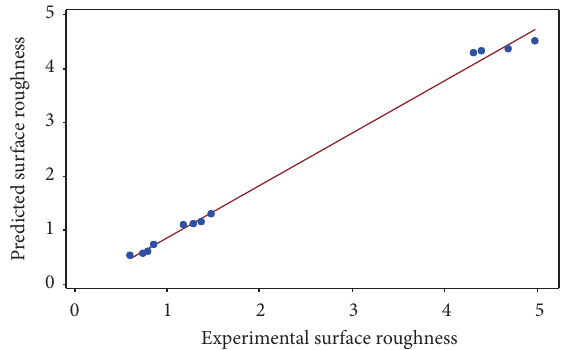
Figure 8: Scatter plot for the predicted versus experimental 𝑅 𝑎 values for the (12) validation runs.